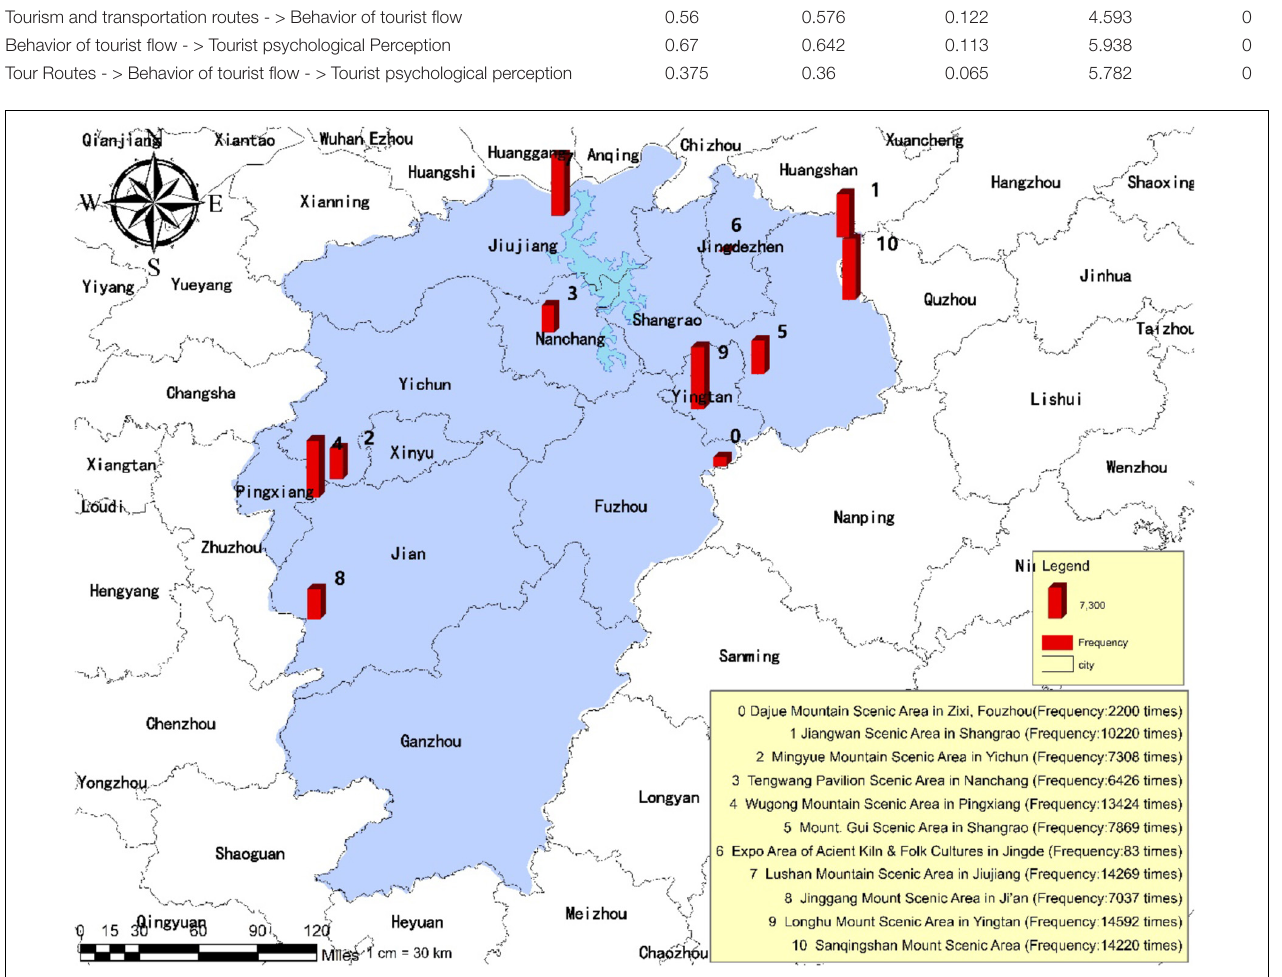
FIGURE 3 | Frequency of tourism destinations in tourist’s psychological